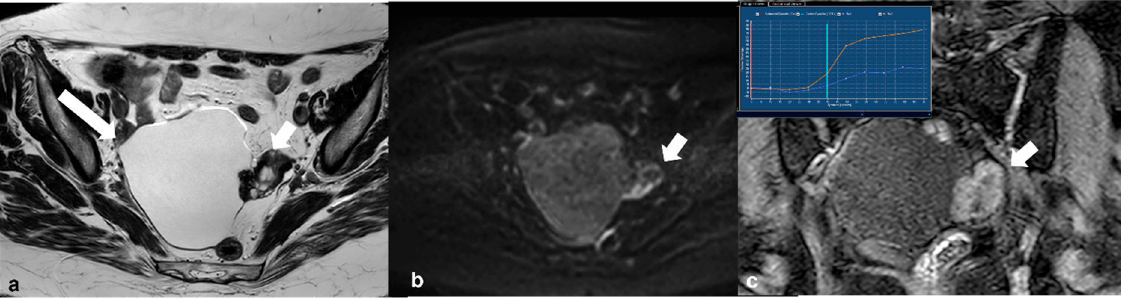
Figure 9. Cystadenofibroma. Axial T2 weighted image ( a ) shows a right-sided ovarian cystic mass (long arrow) with a peripheral solid component of very low signal intensity (short arrow). Corresponding axial high b value (1200) diffusion weighted image ( b ) shows no restricted diffusion of the solid tissue (arrow). Dynamic contrast-enhanced image ( c ) demonstrates avid enhancement of the solid part of the lesion (arrow) and a type 2 time–intensity curve (yellow line: uterus; blue line: lesion in inset).